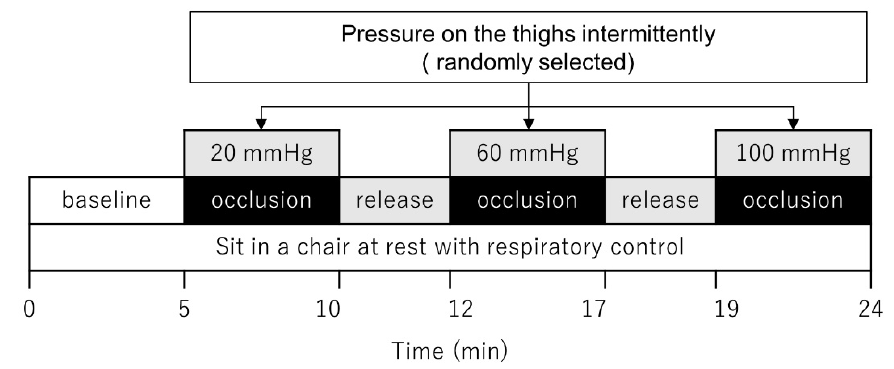
Figure 1. Schematic of the experimental protocol.